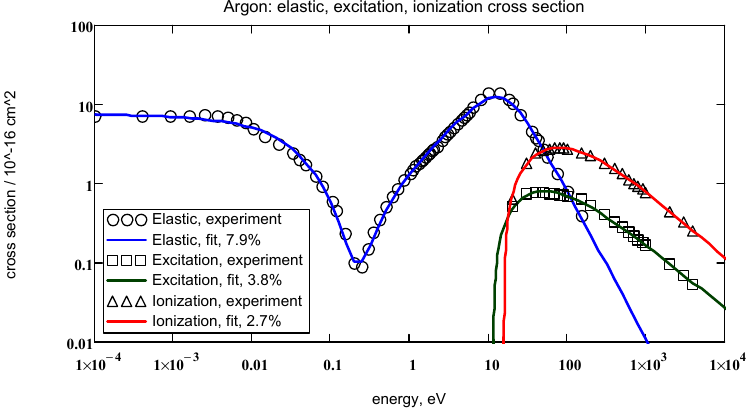
Figure 11. Elastic, excitation and ionization cross sections: experiments and the results of approx- imation for argon atoms.